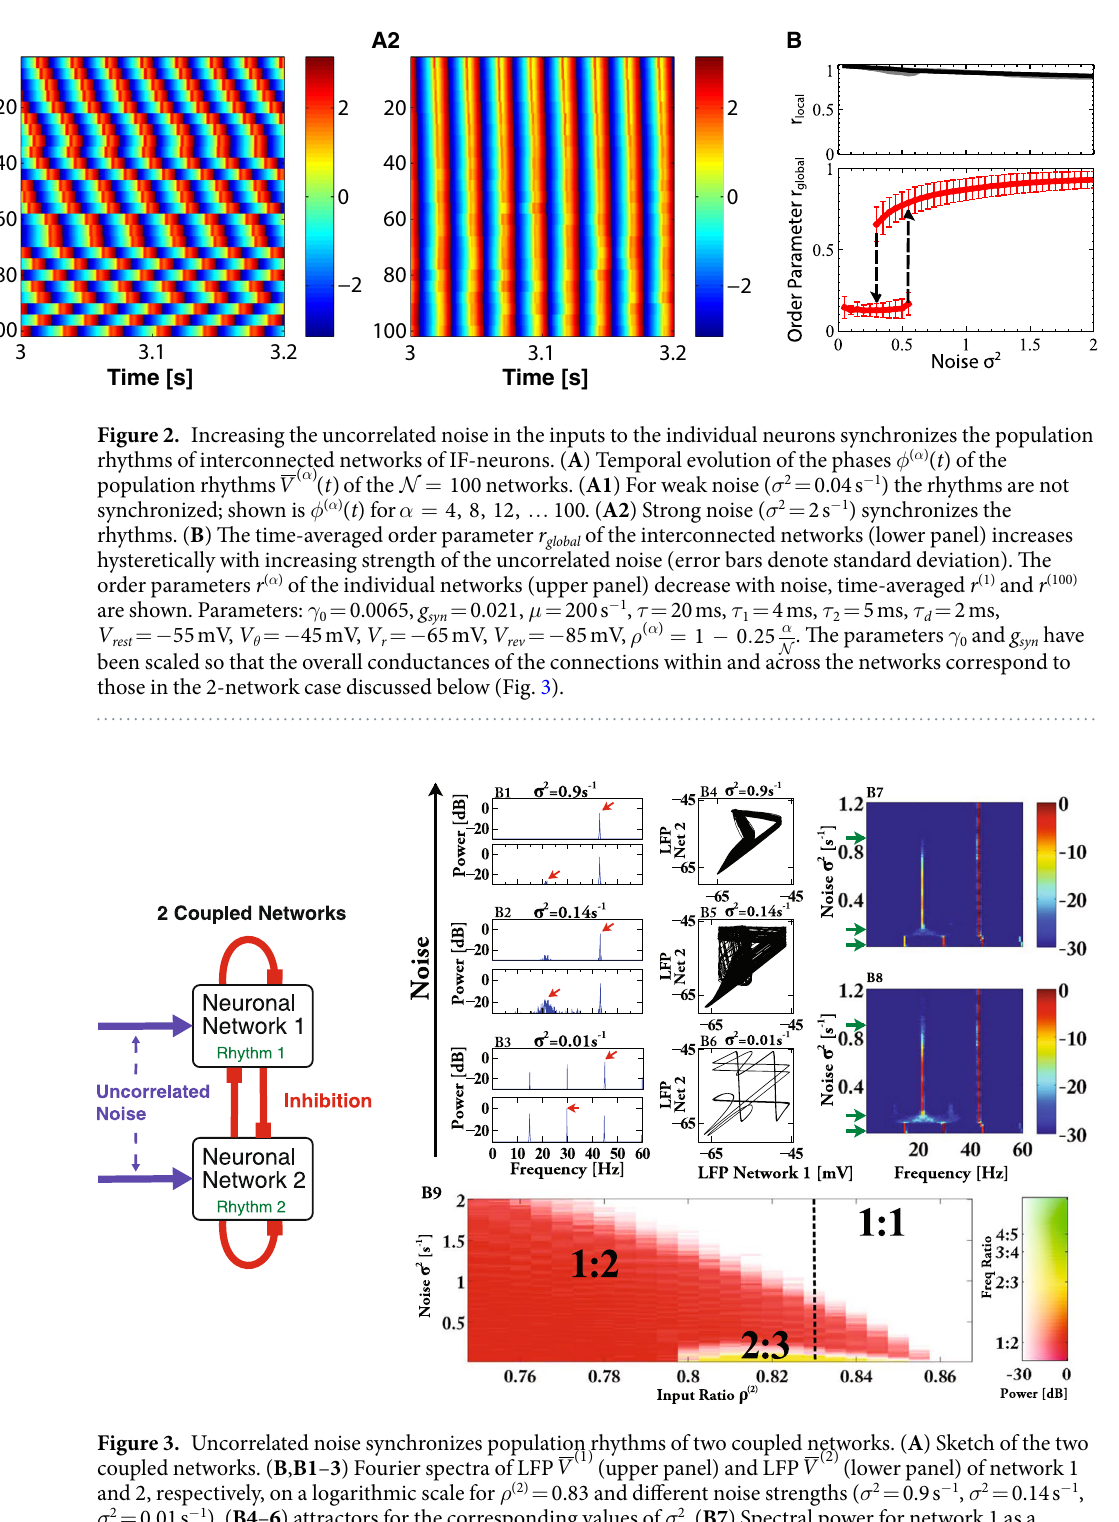
Figure 3. Uncorrelated noise synchronizes population rhythms of two coupled networks. ( A ) Sketch of the two coupled networks. ( B , B1 – 3 ) Fourier spectra of LFP V (1) (upper panel) and LFP V (2) (lower panel) of network 1 and 2, respectively, on a logarithmic scale for ρ (2) = 0.83 and different noise strengths ( σ 2 = 0.9 s − 1 , σ 2 = 0.14 s − 1 , σ 2 = 0.01 s − 1 ). ( B4 – 6 ) attractors for the corresponding values of σ 2 . ( B7 ) Spectral power for network 1 as a function of noise and frequency for ρ (2) = 0.83. Green arrows indicate noise values in ( B1 – 3 ). ( B8 ) as ( B7 ) for network 2. ( B9 ) Phase diagram. Color hue and saturation indicate frequency ratio and logarithmic power ratio of the characteristic Fourier modes (marked with red arrows in panels ( B2,3 )), respectively. Synchronization is obtained in the white region labeled 1:1. Parameters: N α = 500, τ = 20 ms, τ 1 = 4 ms, τ 2 = 5 ms, τ d = 2 ms, V rest = − 55 mV, V θ = − 45 mV, V r = − 65 mV, V rev = − 85 mV, g syn = 0.0042, γ 0 = 0.64, μ = 200 s − 1